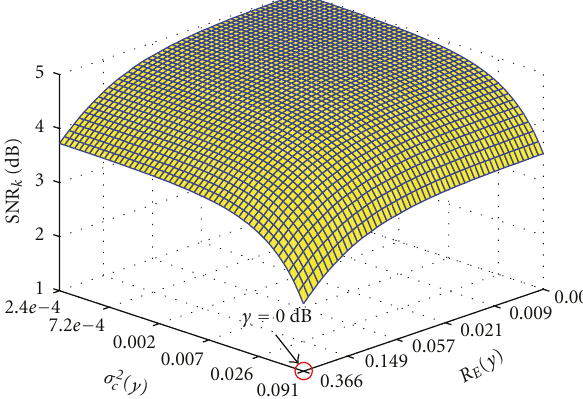
Figure 1: SNR k versus R E and σ 2 c at SNR AWGN, k =